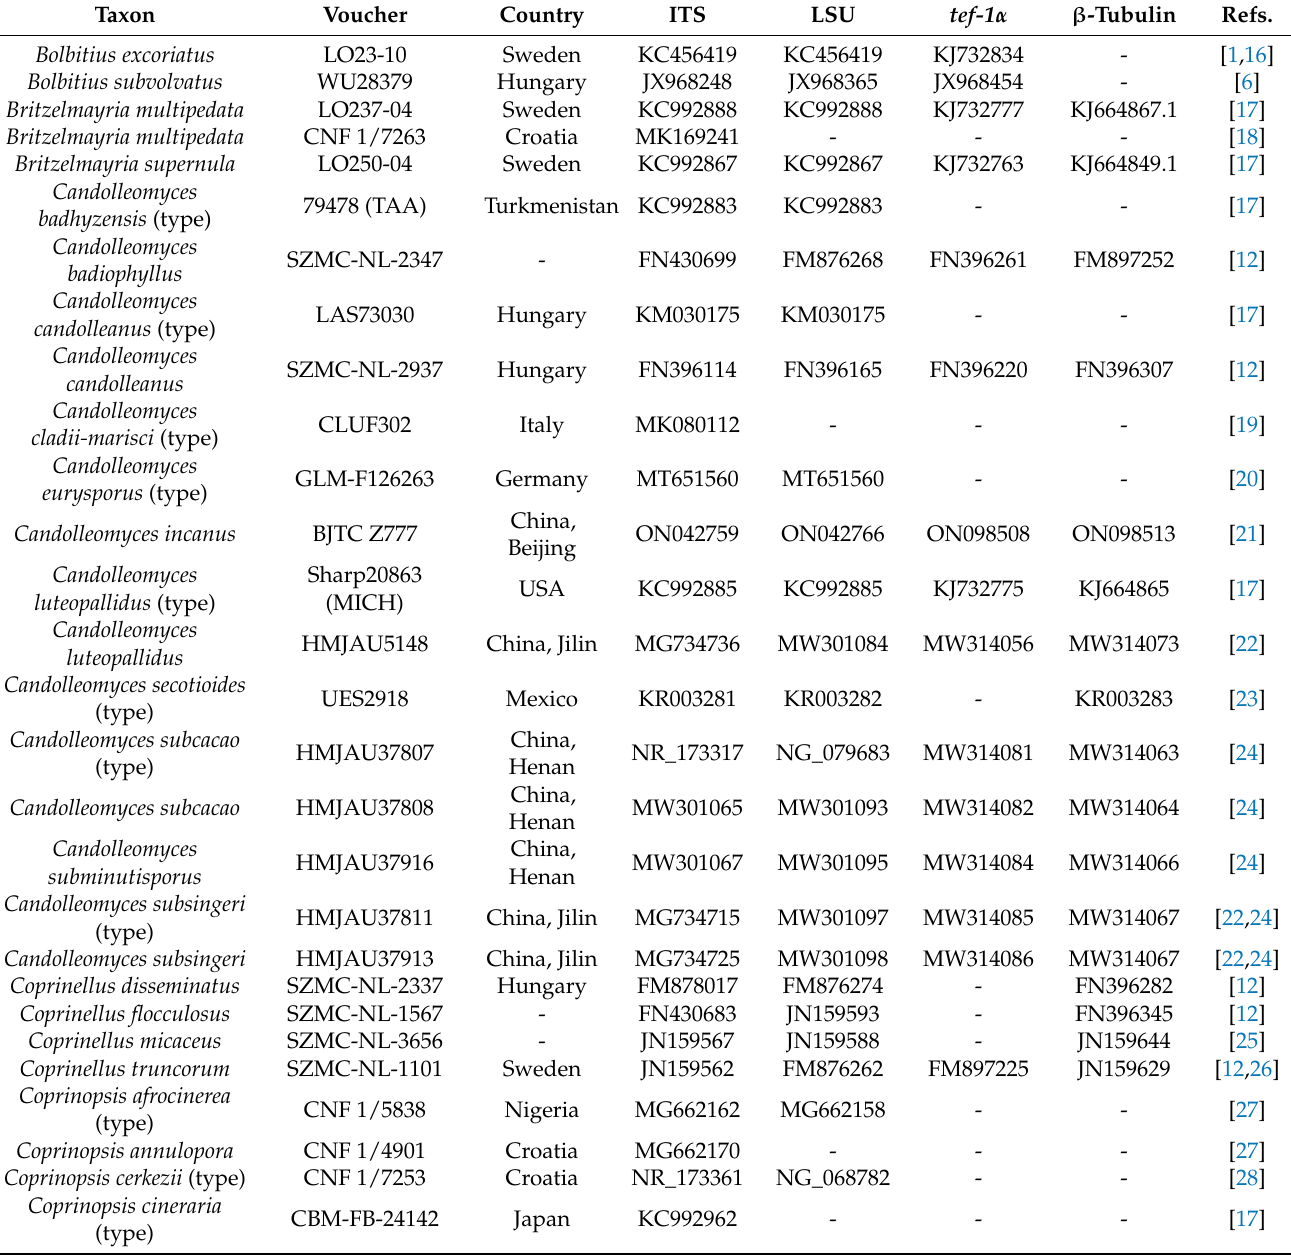
Table 1. Species included in this study, voucher numbers, countries of origin, and GenBank accession numbers. Newly generated sequences are in